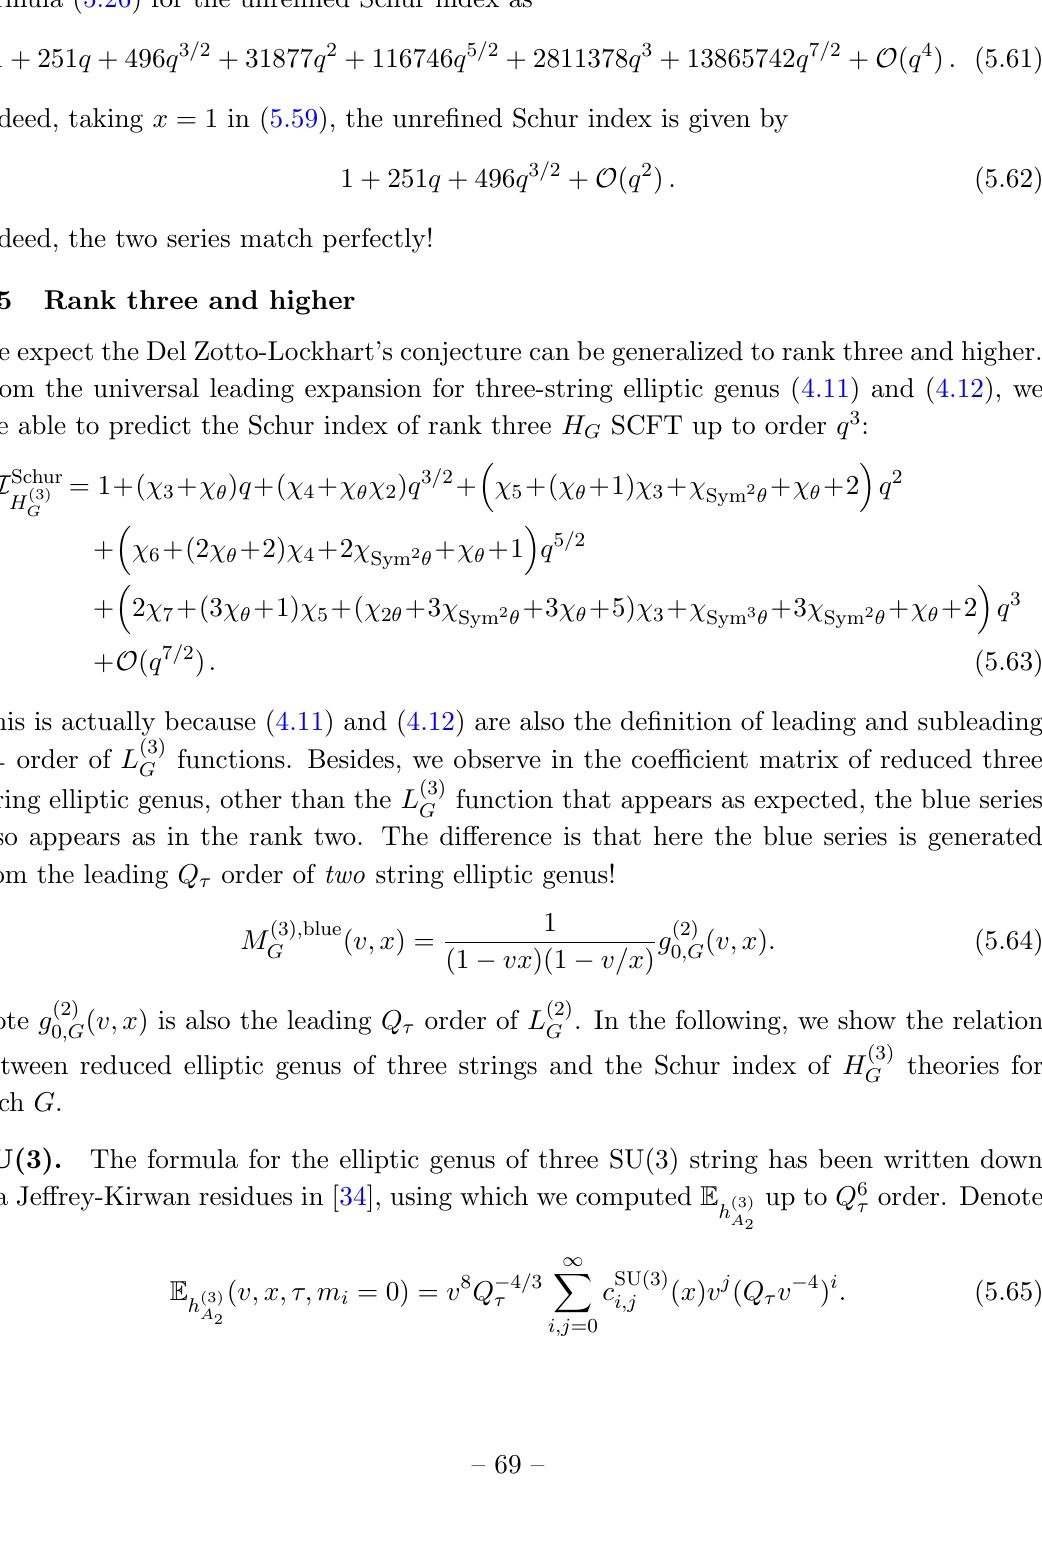
equal to the Schur index of rank two H formula (5.26) for the unre(cid:12)ned Schur index